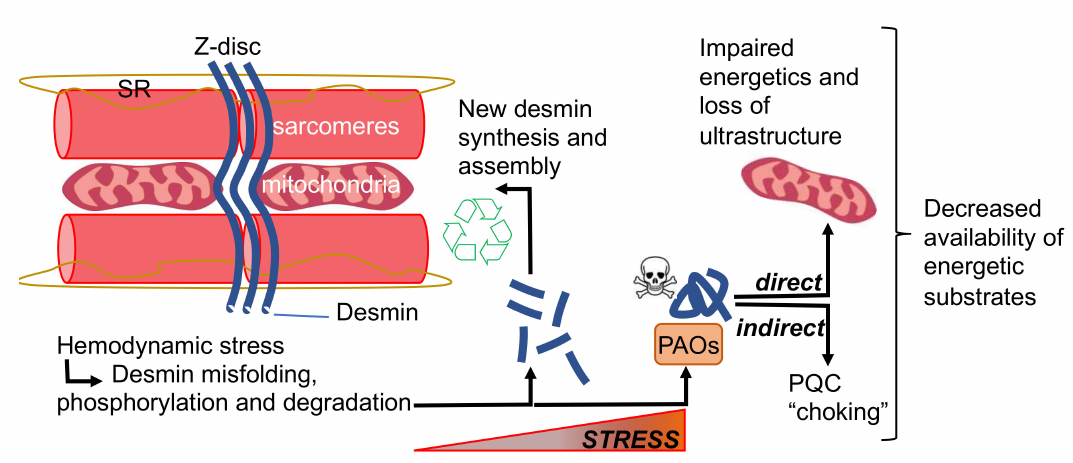
Figure 1. E ff ects of desmin misfolding on energetic substrates availability. PAOs, preamyloid-oligomers; PQC protein quality